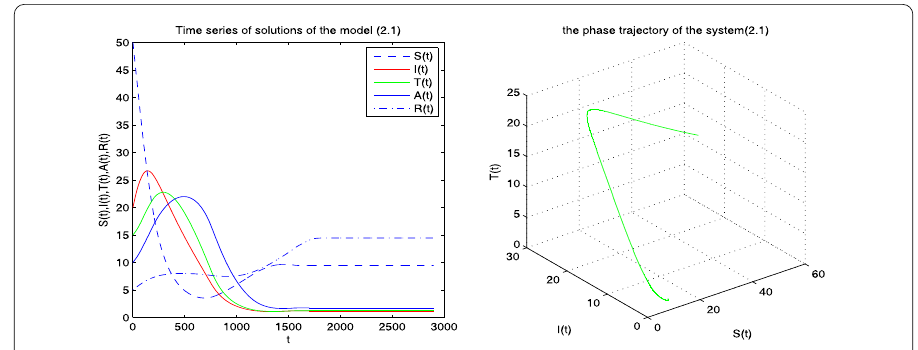
Figure 2 The endemic equilibrium E c of the system (2.1) is globally asymptotically stable.